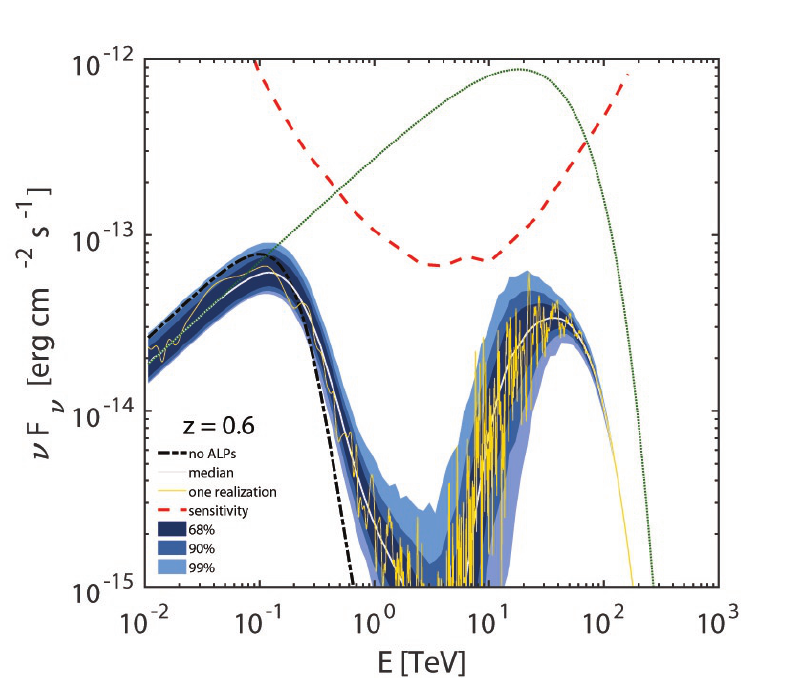
Figure 27. Same as Figure 25 but for a BL Lac at z = 0.6 in the case of observation of the BL Lac along the direction of the galactic pole. (Credit